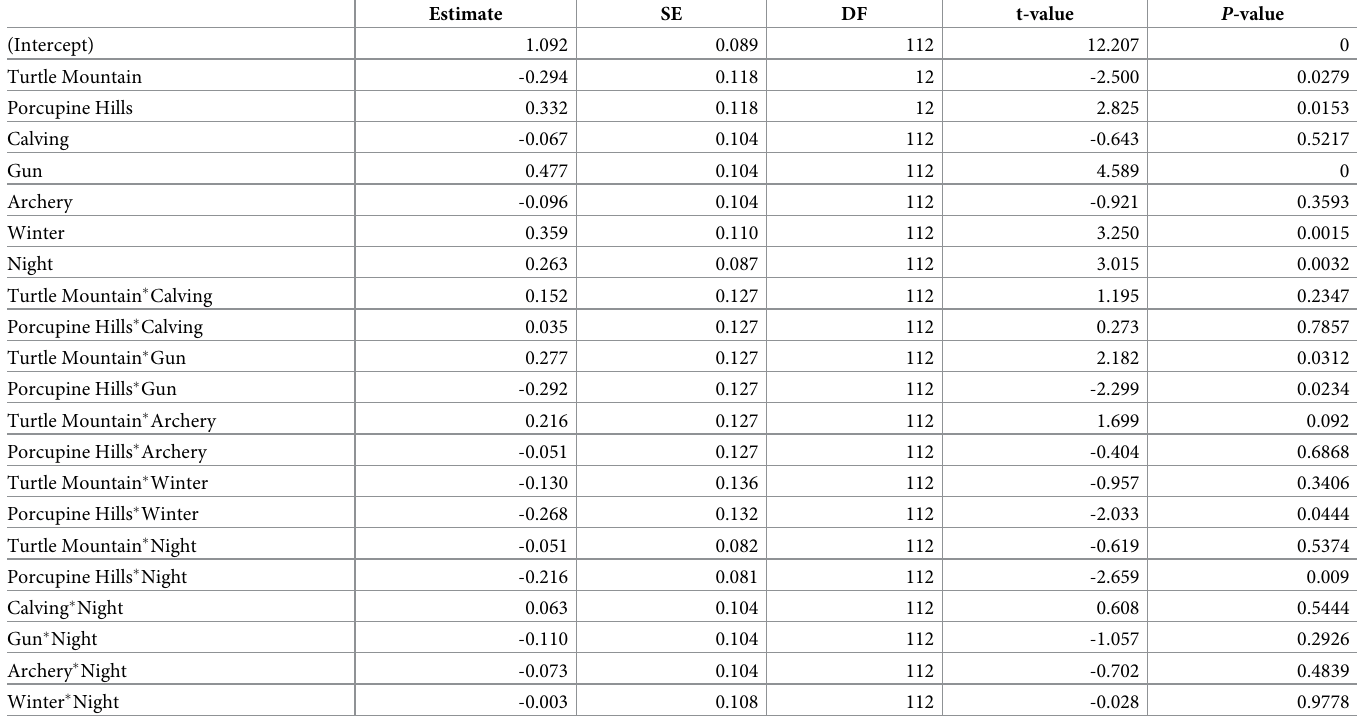
Table 3. Linear mixed effects analysis discerning differences in elk ( Cervus elaphus ) home range sizes using Brownian Bridge Movement Models by season and diel period. Output includes coefficient estimates and standard errors (SE) using log 10 transformed data on 95% home ranges in Turtle Mountain (Turtle), Pembina Hills, and Porcupine Hills (Porcupine) study areas, North Dakota, USA (data collected from